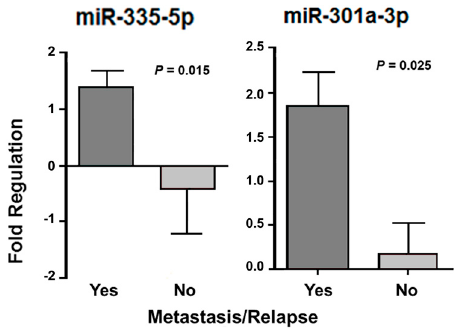
Figure 6. miRNAs with significant differential expression according to the presence of metastasis and/or relapse after treatment in patients with LMS.